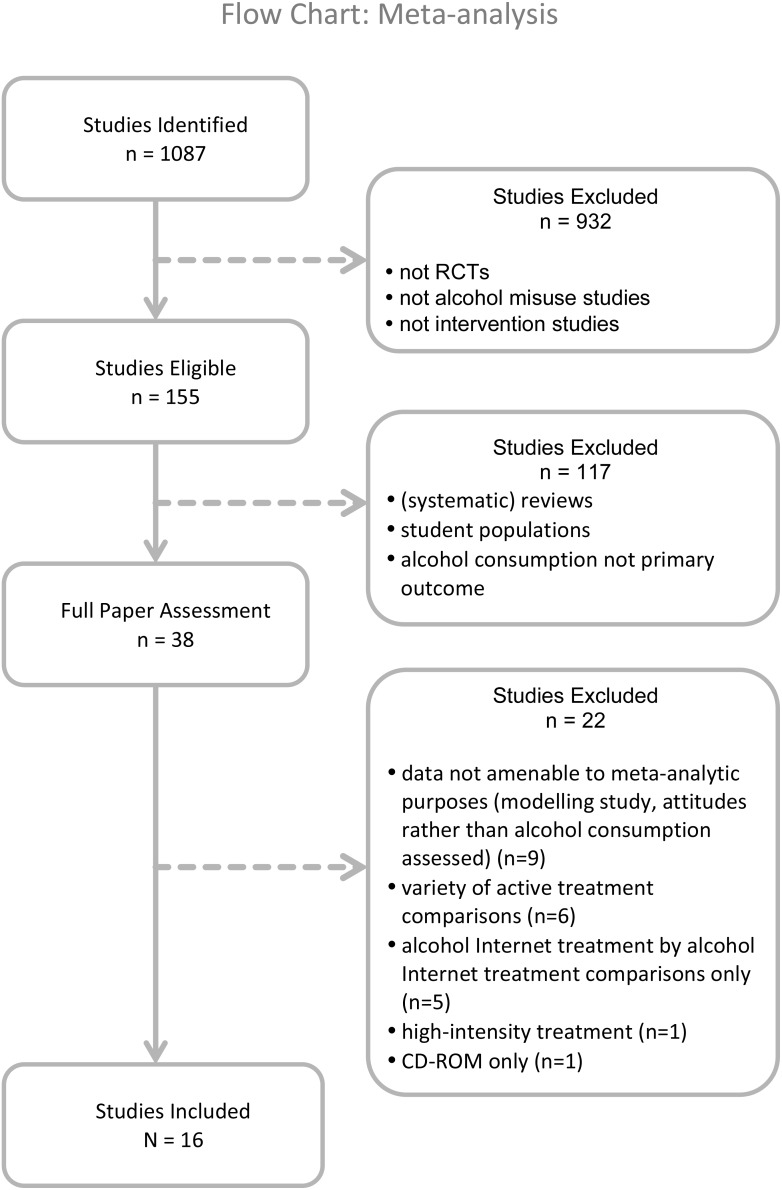
Study inclusion meta-analysis: flow chart.